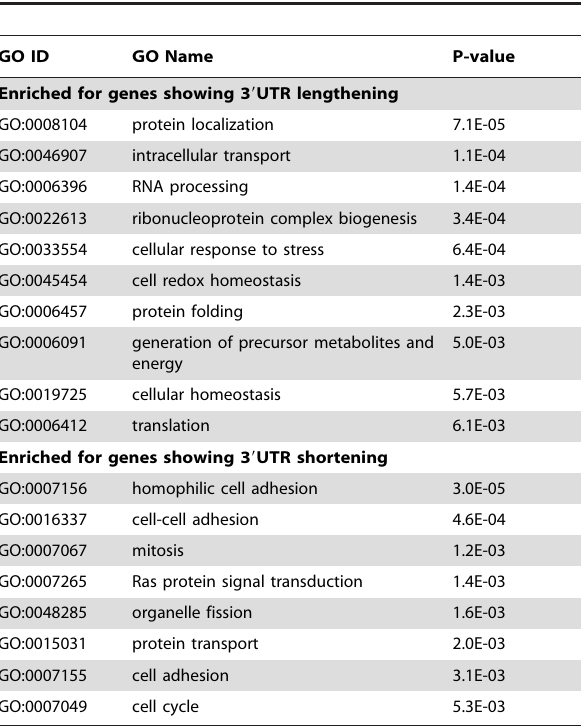
Table 2. Gene Ontology terms enriched for upregulated and downregulated genes after CstF-77